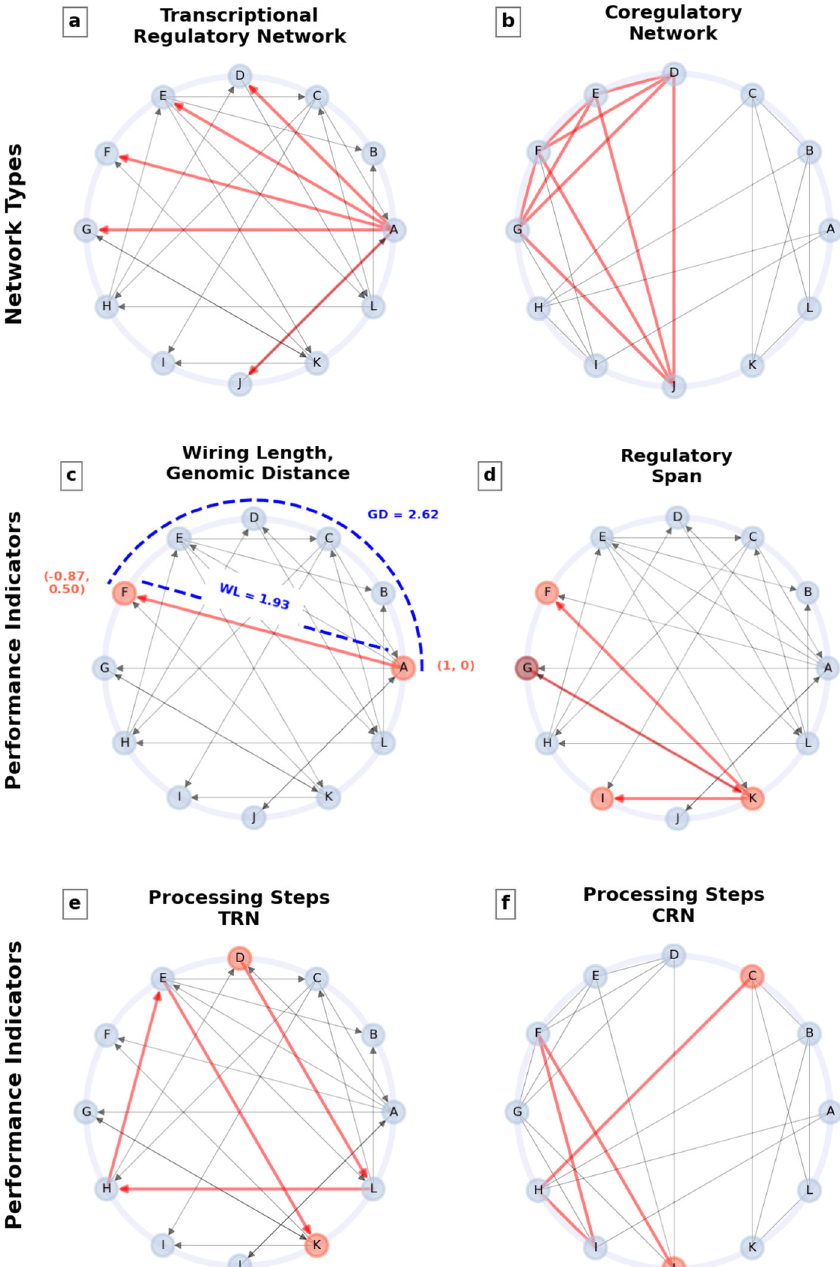
Fig. 2 Schematic representation of the main quantities of our investigation. a TRN. Directed edges represent the regulatory action of the TF encoded by the regulator gene/operon, pointing to the regulated gene/operon. Red edges highlight the regulation of nodes D, E, F, G, and J by node A. b CRN. Nodes are the genes/operons, as in the TRN, but edges connect pairs of genes/operons coregulated by a third gene/ operon. Nodes D, E, F, G, and J are all connected (red edges) due to their joint regulation by node A. c Wiring length (WL) and Genomic distance (GD). The wiring length of the edge from node A to F corresponds to the spatial (Euclidean) distance between the centers of the nodes A and F (WL = 1.93). For each pair of connected nodes, we also consider the arc length between the centers of the nodes, i.e. genomic distance (GD = 2.62). d Regulatory span of node G. e, f Number of processing steps in the TRN ( e ) and the CRN ( f ). The number of processing steps is the average number of steps along the shortest path between nodes. In the TRN, for the node pair (D, K), the number of steps along the shortest path D-L-H-E-K is 4. In the CRN nodes C and J are linked via four processing steps. This number is 1 for node pairs related by an edge (direct association between regulators and regulated genes and their (with z-scores between − 14.86 and − 13.68 on the gene level). Even though source-target node pairs (edges) or node positions positions, play an important role in improving wiring economy. We investigate this nonrandom property of the embedded are randomized via three different methods, we observe similar network also by performing all the analyses using genomic wiring length distributions for each null model, which indicates that both source-target pairs and node positions, i.e., both the distance instead of wiring length (see Methods) to account for